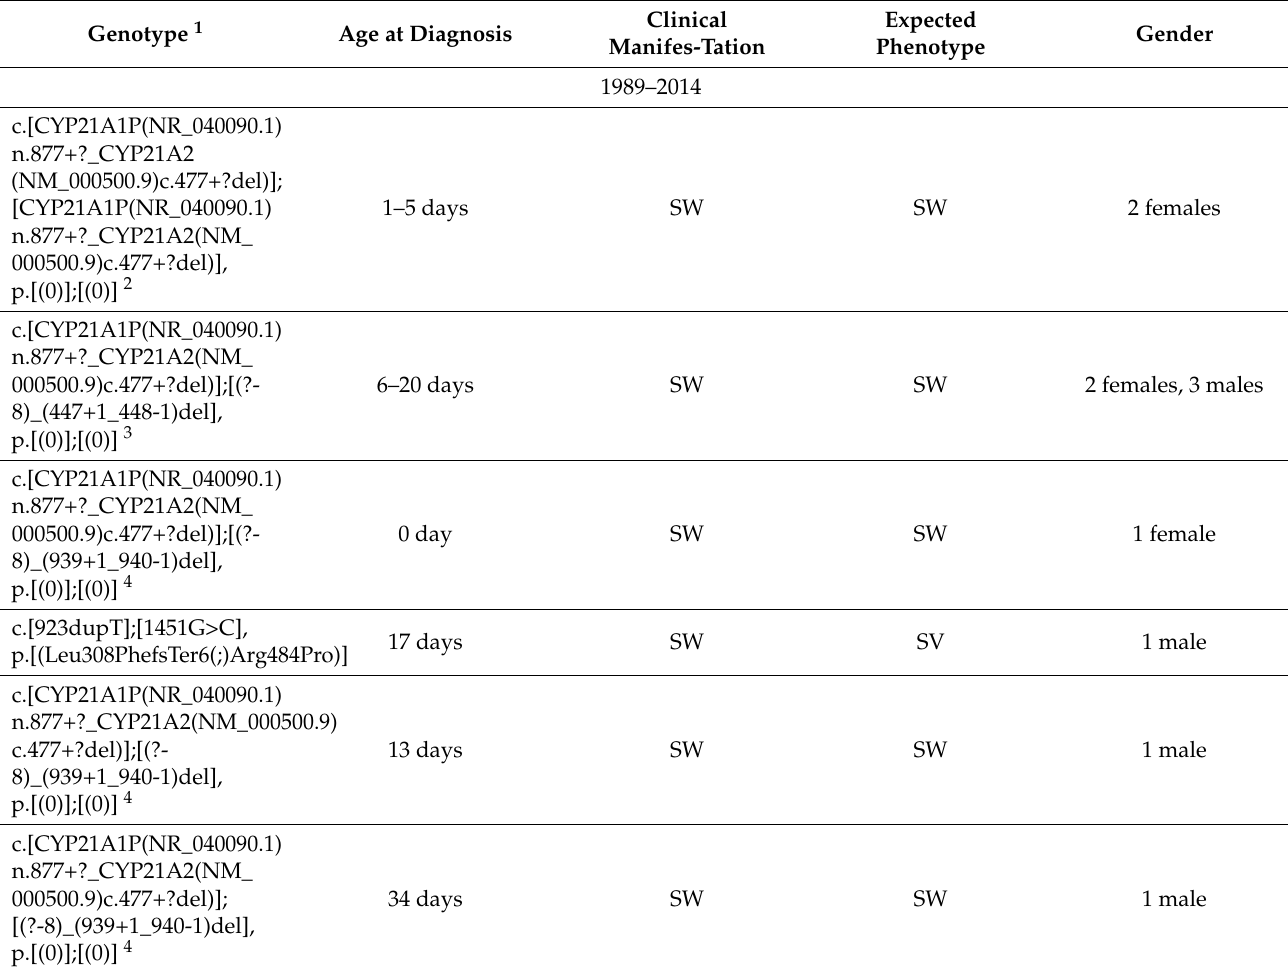
Table 5. Genotypes of all investigated patients due to 21OHD in